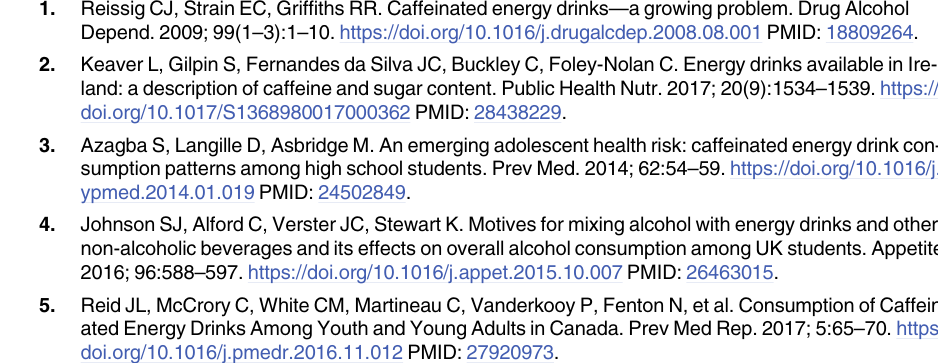
S1 Table. Multinomial logistic regression analyses with complex sampling of subjective stress level, sleep time, and self-assessment of school performance for high energy drink- ing. S2 Table. Ordinal logistic regression analyses with complex sampling of subjective stress level, sleep time, and self-assessment of school performance for high energy drinking in each male and female group. S3 Table. Multiple logistic regression analyses with complex sampling of high energy drink for suicide trial in each male and female